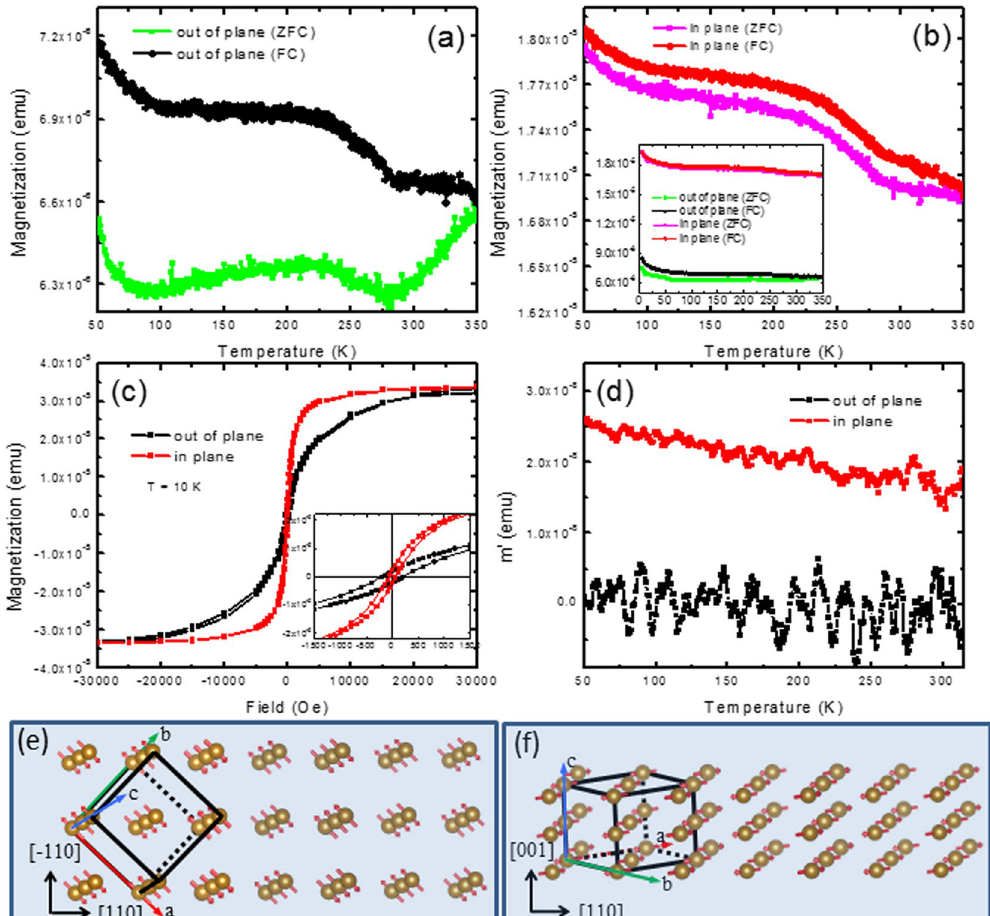
Figure 3. Anisotropic magnetic properties of FeGe 2 nanowires. Temperature-dependent ZFC and FC magnetic moments when magnetic field was applied at out-of-plane direction ( a ) and in-plane direction ( b ), H = 1000 Oe. The inset of ( b ) shows the direct comparison of the out-of-plane and in-plane ZFC and FC data. ( c ) Field- dependent magnetization at 10 K for out-of-plane and in-plane, the inset is the zoom in the magnetization. ( d ) The initial ac susceptibilities under 0 field for out-of-plane and in-plane. ( e ) and ( f ) The schematic drawing of the relation among the two structure models of FeGe 2 , growth direction of the nanowires and the spin alignment of Fe atoms, with short axis in [ − 110] and [001]